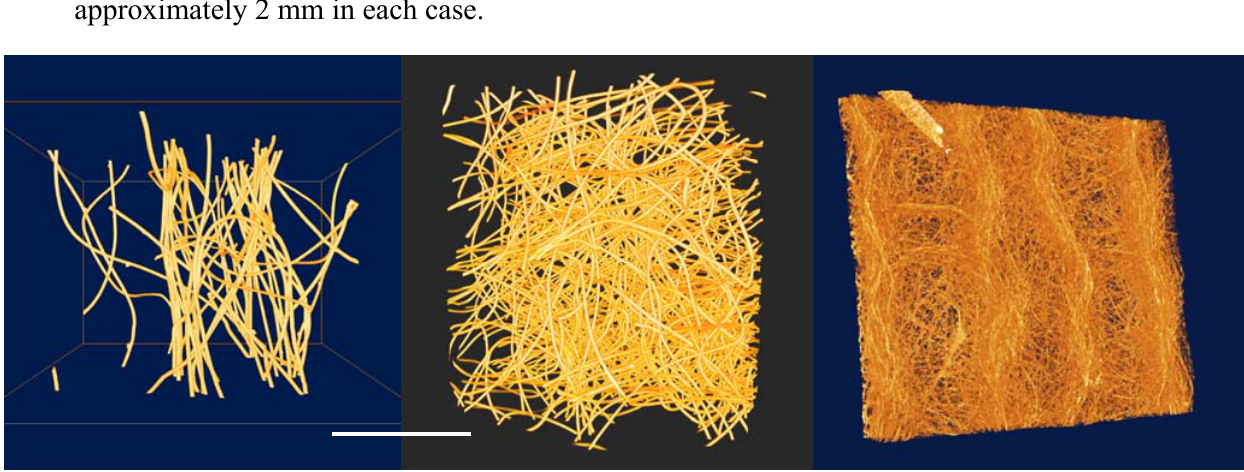
Figure 9. 3D rendered views of tomographic datasets for each of the three scaffolds, the electro-spun scaffold is on the right and is ~100 μ m thick. The width of the samples is approximately 2 mm in each